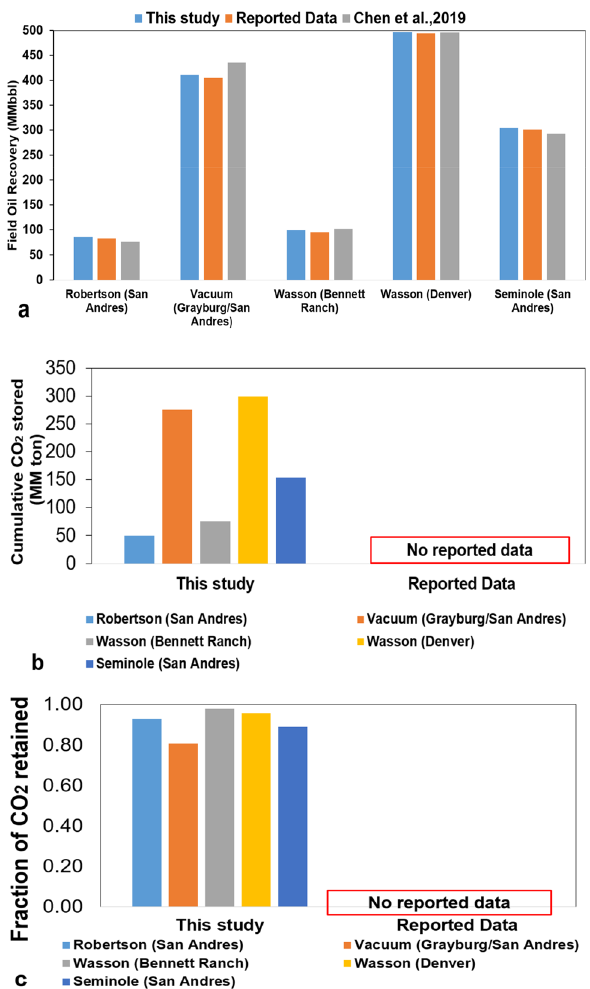
Figure 8. The prediction results of data-driven ANN models for field application in the Permian Basin. ( a ) Comparing between oil production calculated from ANN model and the values recorded in the study of Koperna and Kuuskraa (2006) and Chen et al. (2019). ( b ) The predicted cumulative CO 2 stored from ANN models. ( c ) The predicted fraction of CO 2 retained from ANN